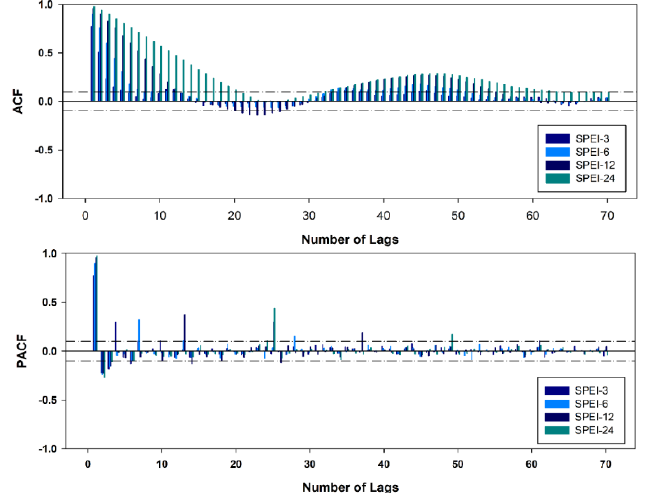
Figure 5. Autocorrelation function (ACF) and partial autocorrelation function (PACF) based on a periodicity of 12 months for model selection at different Standardized Precipitation Evapotranspiration Index (SPEI) time